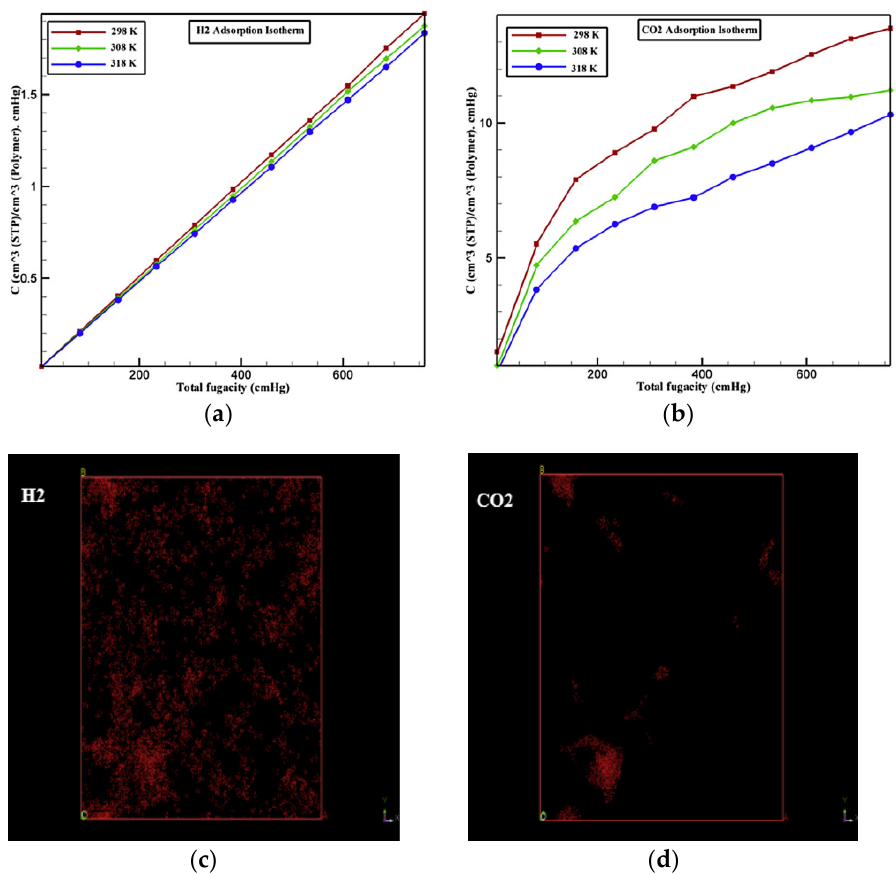
Figure 20. The isotherm adsorption curves of CO 2 ( a ) and H 2 ( b ) in the polymer membrane; the adsorption sites of H 2 ( c ) and CO 2 ( d ) in polyurethane [49].